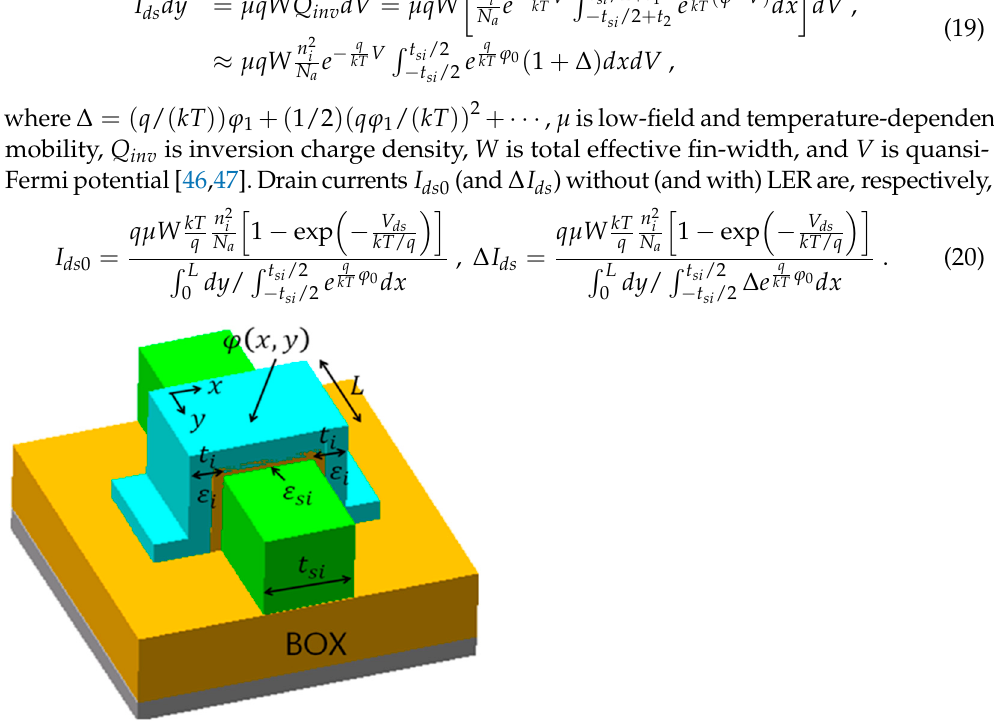
Figure 2. Schematic description of a 3D FinFET device.